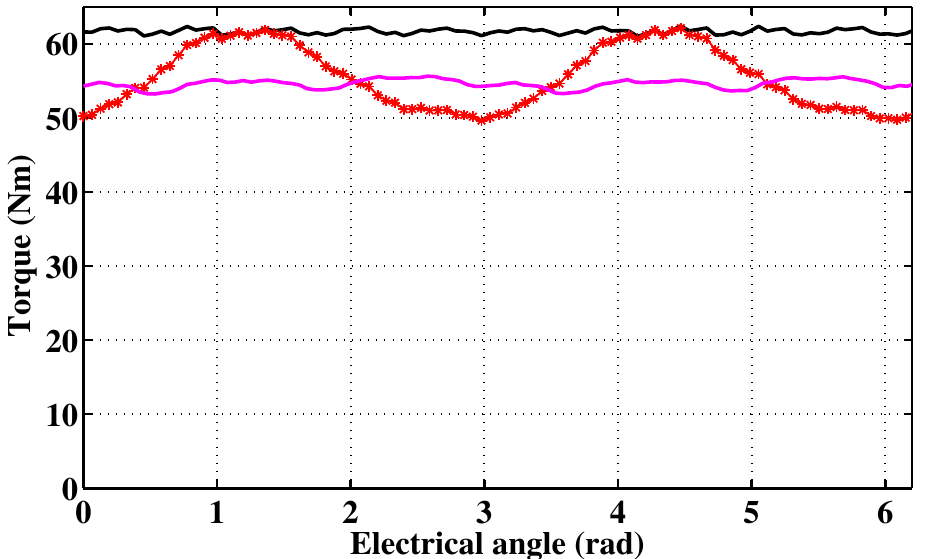
Figure 21. Torque-angle characteristics for the coil rated current rms value of 14 A in the case of the proposed armature winding arrangement. Legend: (pink) one-coil open-circuit fault with readjustment of the phase currents, (red stars) one-coil open-circuit fault without readjustment of the phase currents, (black) healthy